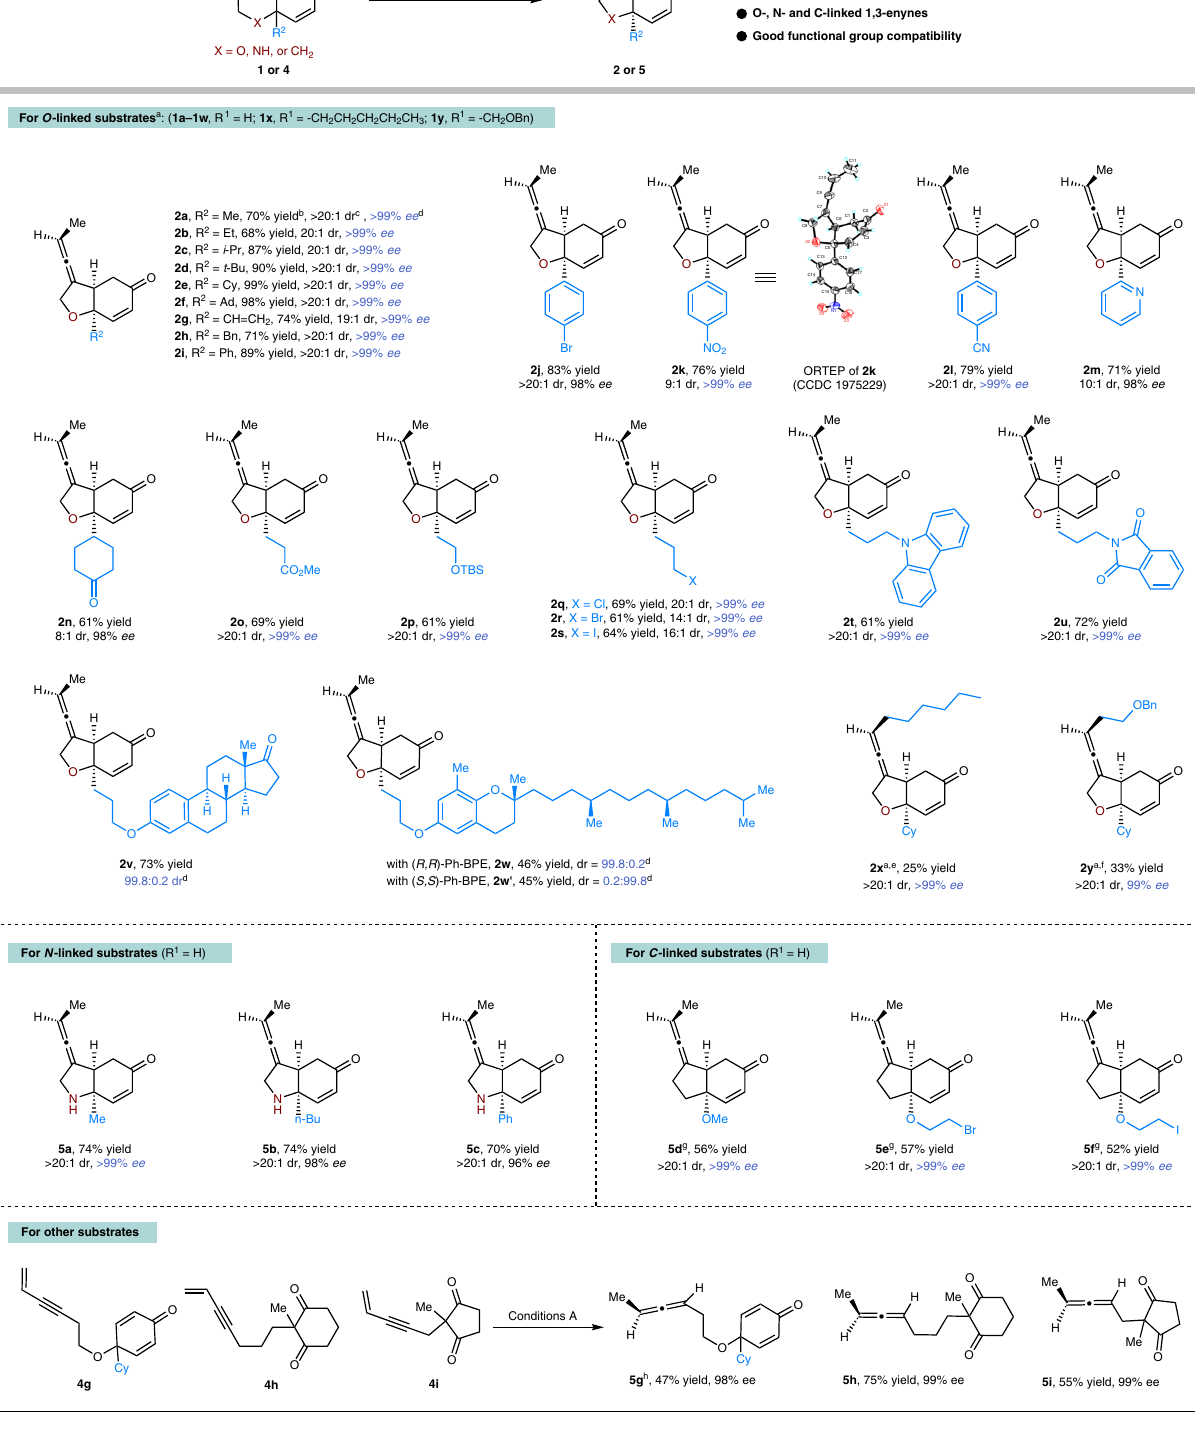
Fig. 3 Reaction scope of 1,3-enyne-tethered cyclohexadienones. a Conditions A : Reactions were performed using 1,3-enyne 1 (0.2 mmol), PMHS